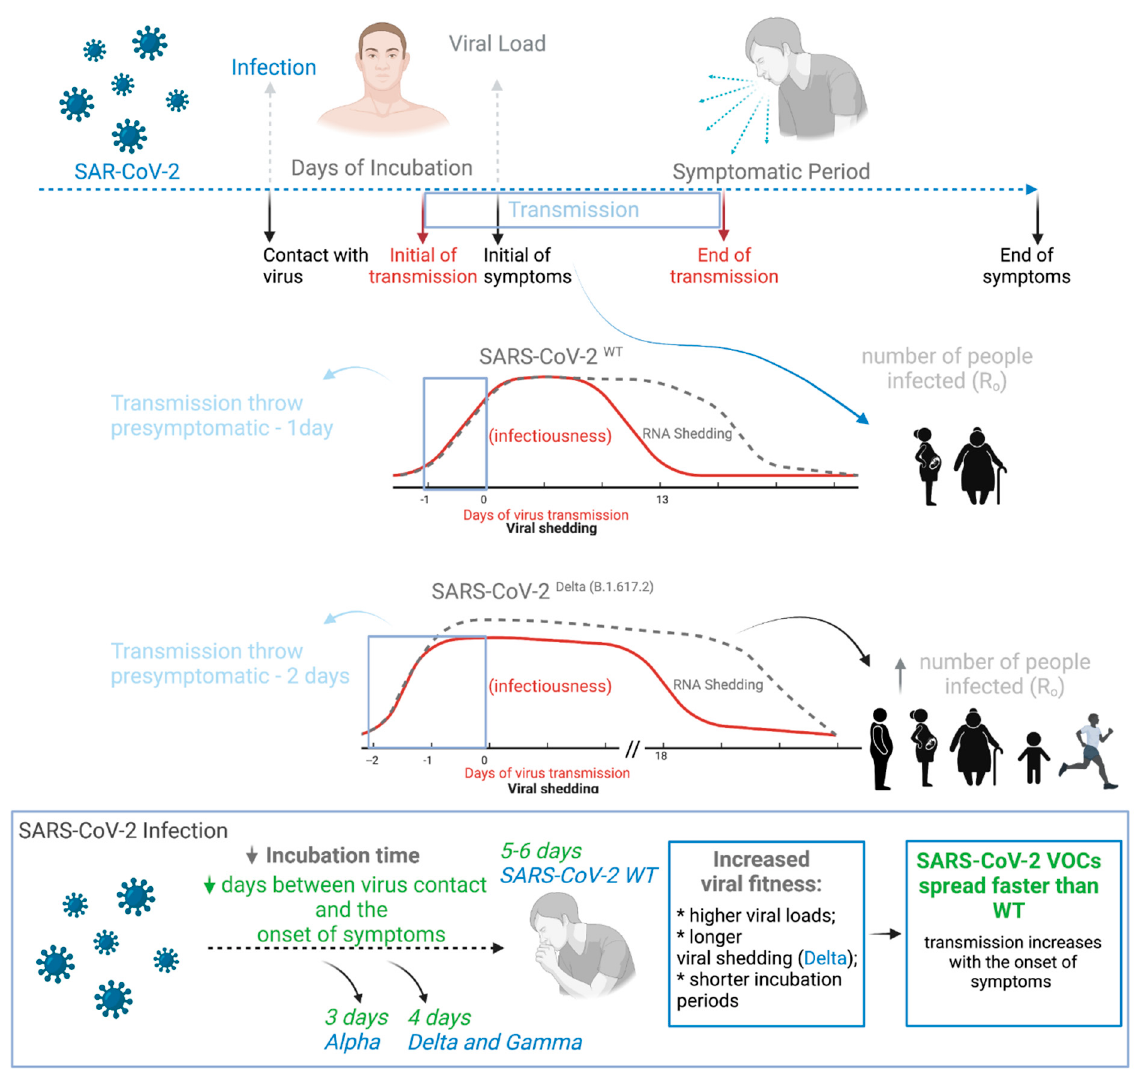
Figure 2. The kinetics of SARS-CoV-2 infection. The SARS-CoV-2 infection involves contact with the virus, viral incubation (days of presymptomatic viral replication), period of viral transmission (viral shedding, shown in the red line in the graphs), which is associated with increased viral loads in the infected person, the symptomatic period, from symptoms onset to recovery and the window for detection of viral RNA by diagnostic tests (viral RNA shedding, gray dashed lines in the graphs).